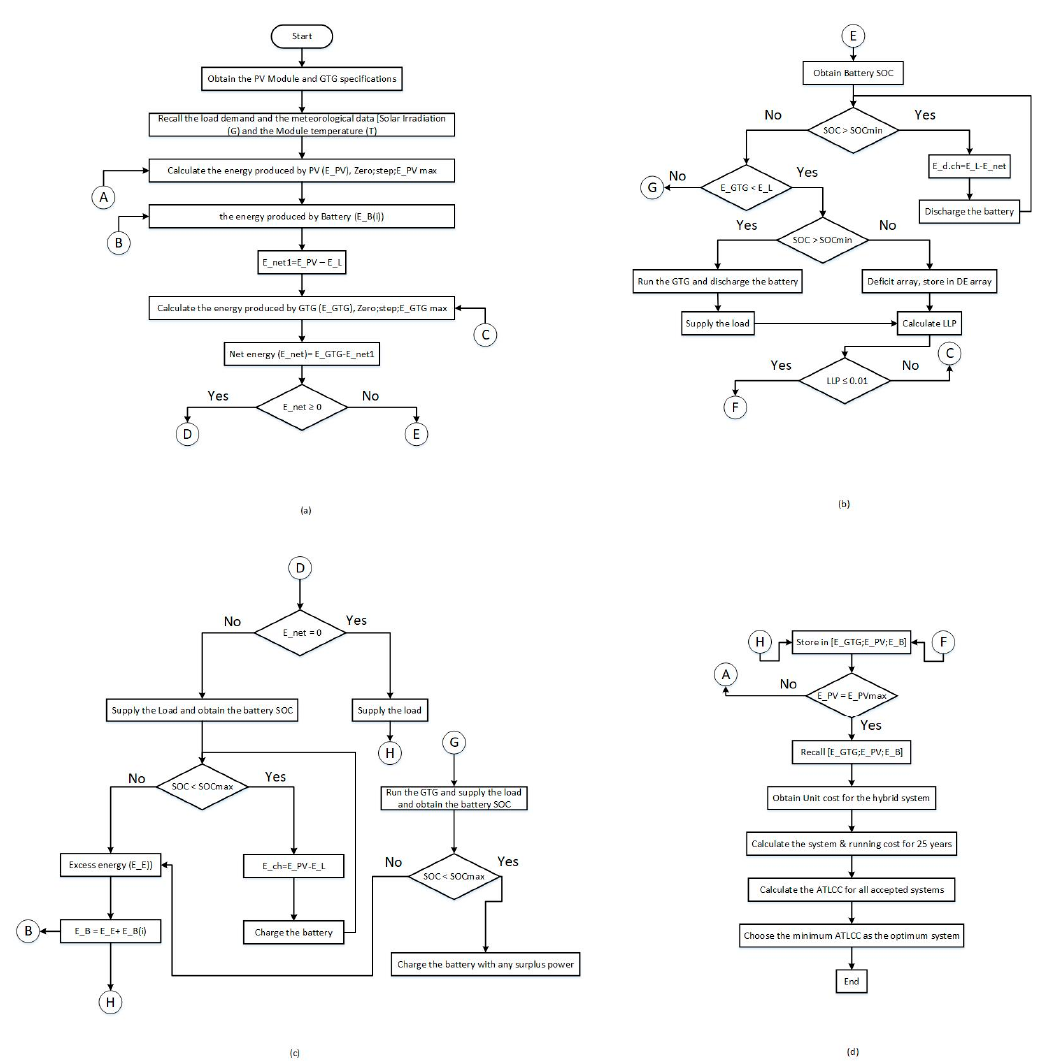
Figure 4. Proposed algorithm: ( a ) data calling and system specifications, ( b ) the deficit energy section, ( c ) the excess energy section and ( d ) optimum sizing options with cost calculations .